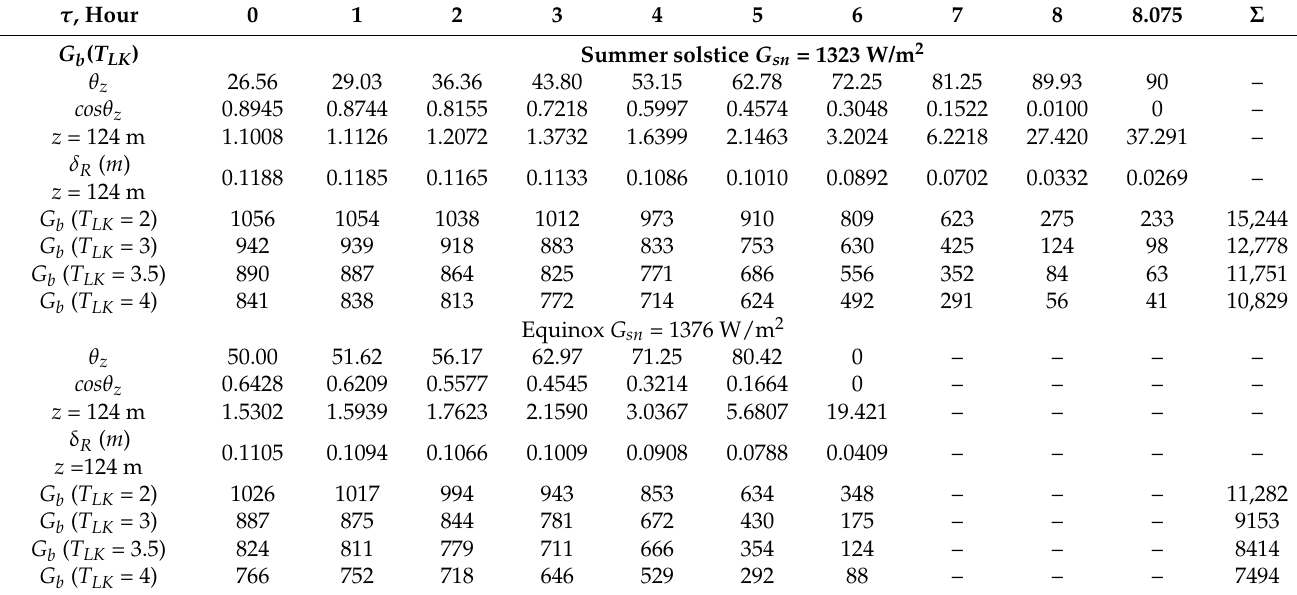
Table 3. Intensity of direct flux G b at the latitude 50 ◦ ; (own